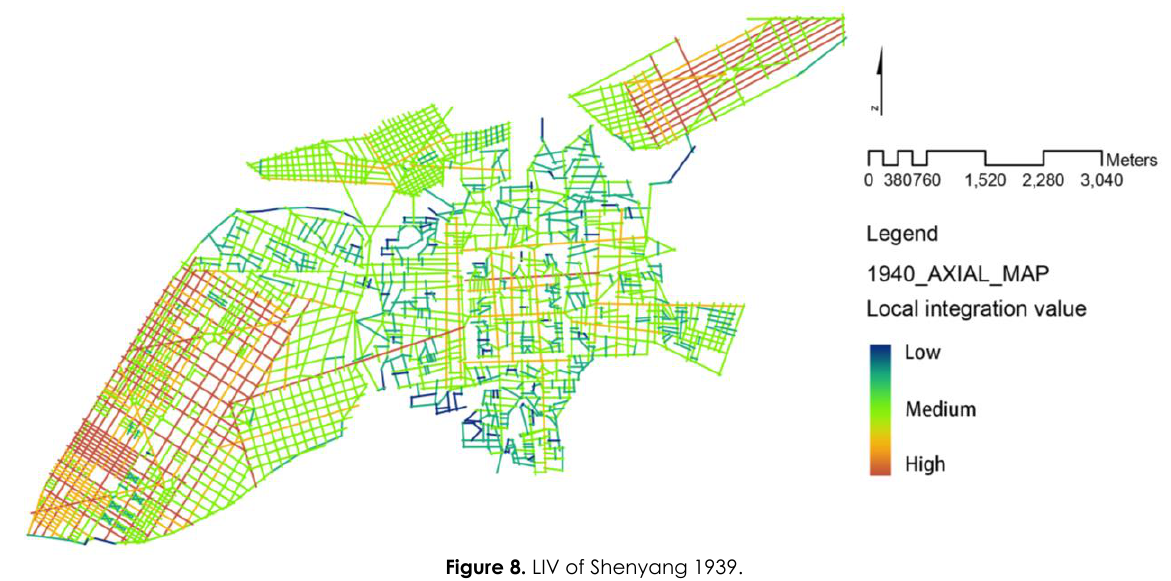
Figure 8. LIV of Shenyang